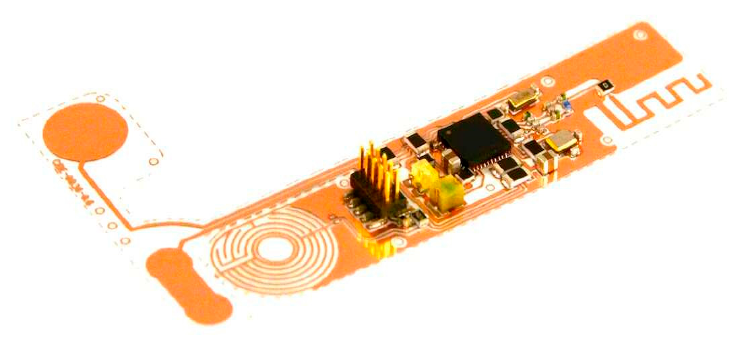
Figure 3. Bluetooth sensor circuit mounted on a flexible substrate. Source: https://www.edn.com/product-how-to-build-your-own-designs-on-flexible-circuit-boards (ac- cessed on 20 March 2021).